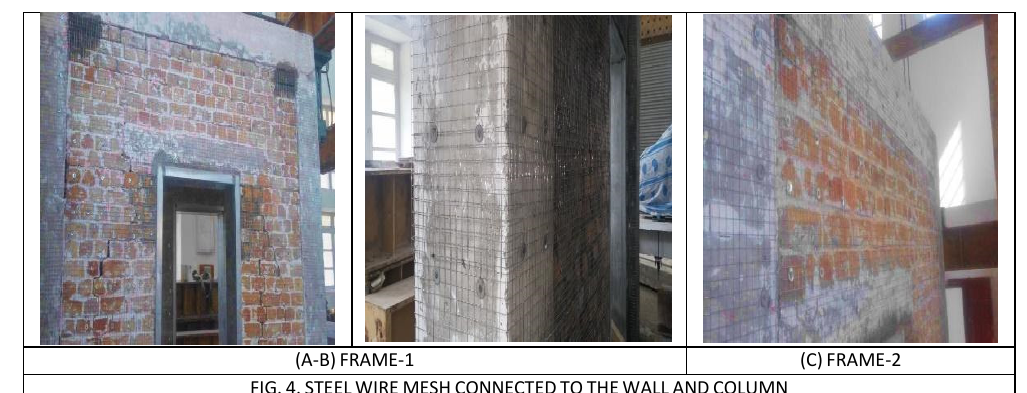
FIG. 4. STEEL WIRE MESH CONNECTED TO THE WALL AND